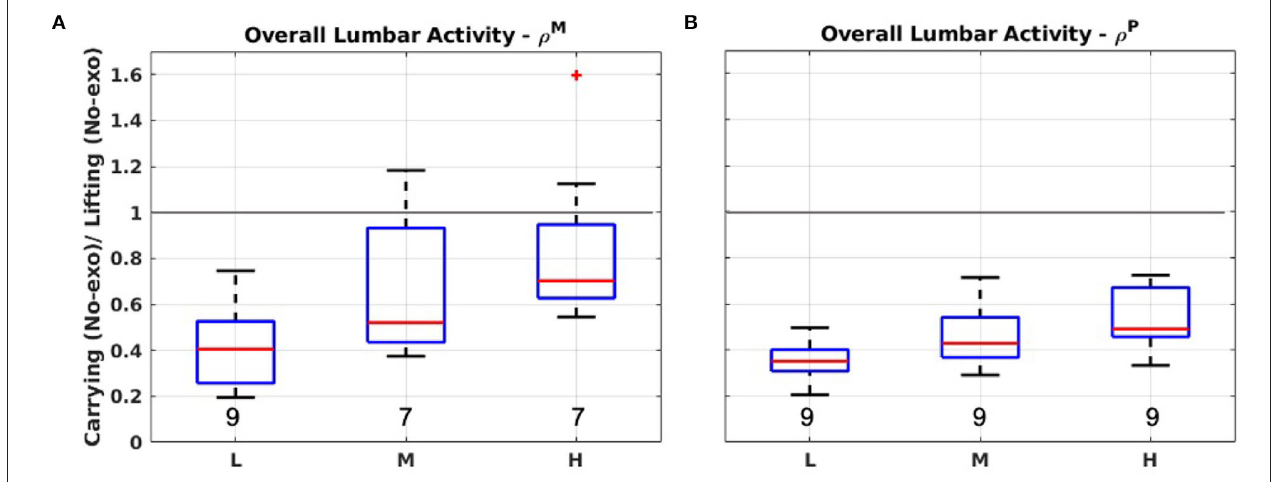
FIGURE 3 | Boxplot representations for ρ M and ρ P considering the overall lumbar muscle activity performing lifting and carrying in No-exo condition. (A) The 50th percentile of muscle activation ( ρ M ). (B) The 90th percentile ( ρ P ). L, M, and H refer to the light, medium, or heavy loading condition. A gray line identifies where ρ = 1 (i.e., where carrying and lifting are equivalent according to the selected metric). Numeric values at the bottom of each box report the value of γ